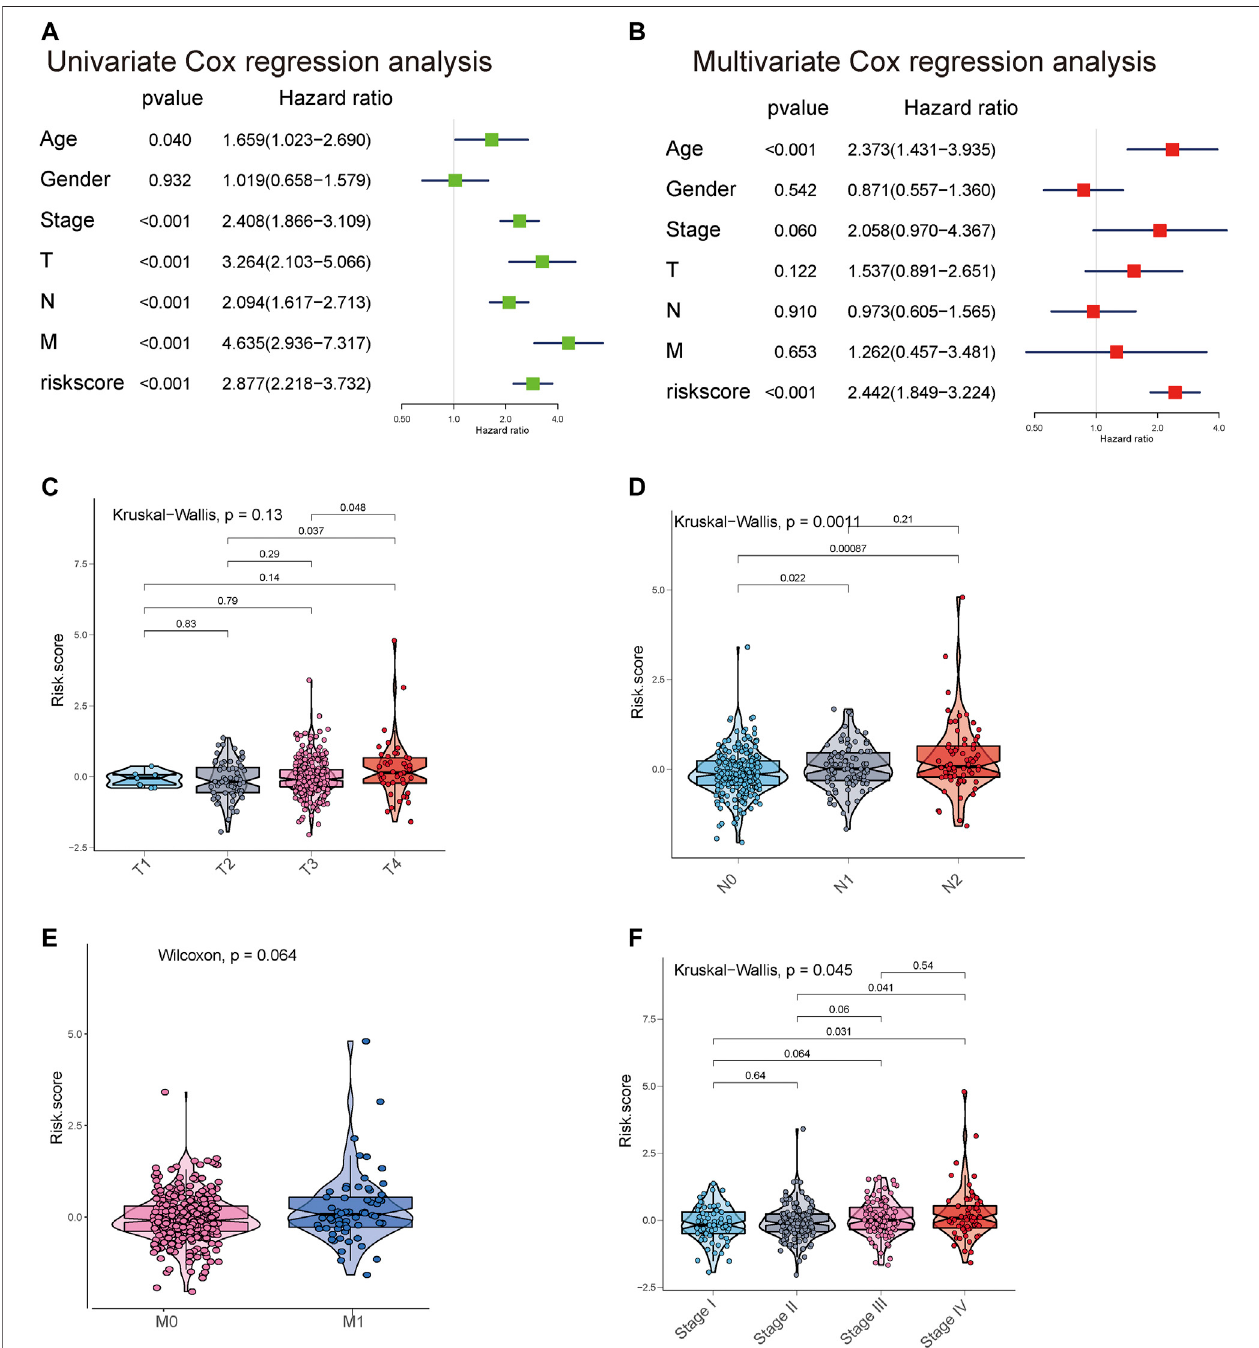
FIGURE5 | Univariate and multivariate analyses showed the prognostic value ofthe 8-lncRNA signature inthe TCGA cohort. (A,B) Univariate and multivariate Cox regression analyses of the association between clinicopathological factors and OS of CRC patients. (C – F) The boxplot shows the risk score in T classi fi cation, N classi fi cation, M classi fi cation, and